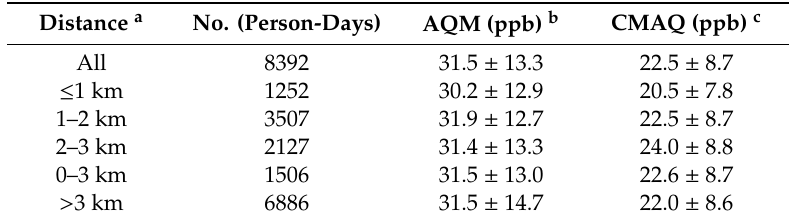
Table 2. Comparison of NO 2 exposure levels by AQM measurements and CMAQ predictions.